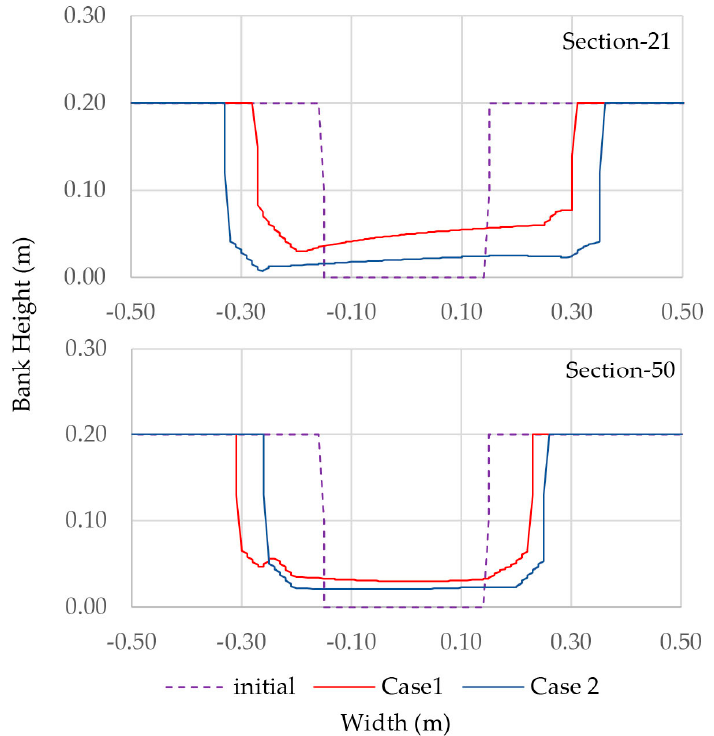
Figure 7. Comparison of cross sectional evolution for cases 1 and 2 in the straight part of the channel (S-50) and the curved part of the channel (s-21) for a simulation time of 21,600 (s).